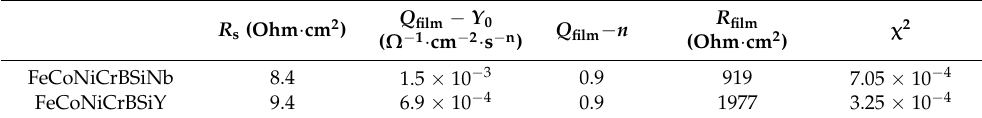
Table 6. A series of electrochemical parameters fitted from the EIS curves.